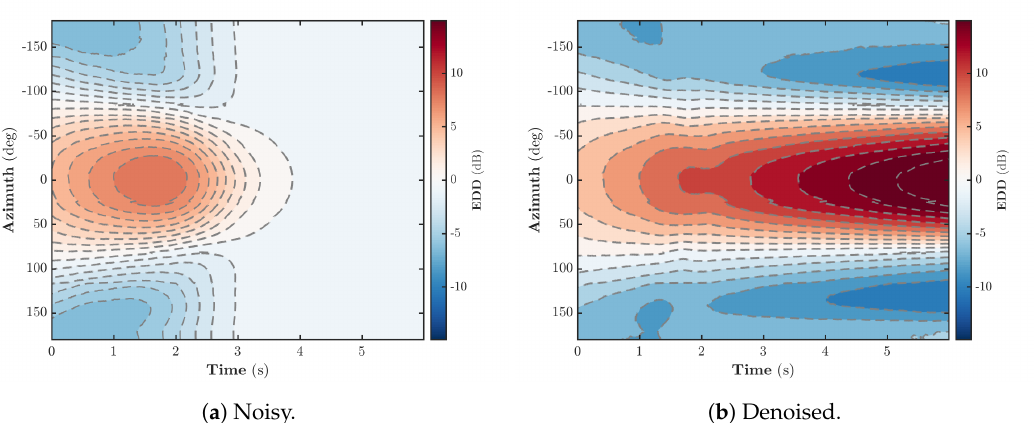
Figure 4. Energy decay deviations (EDD) of ( a ) the simulated noisy late reverberation tail and ( b ) the result of applying the proposed denoising process. EDDs are calculated over PWD look directions and projected onto the azimuthal plane by cubic Hermite spherical